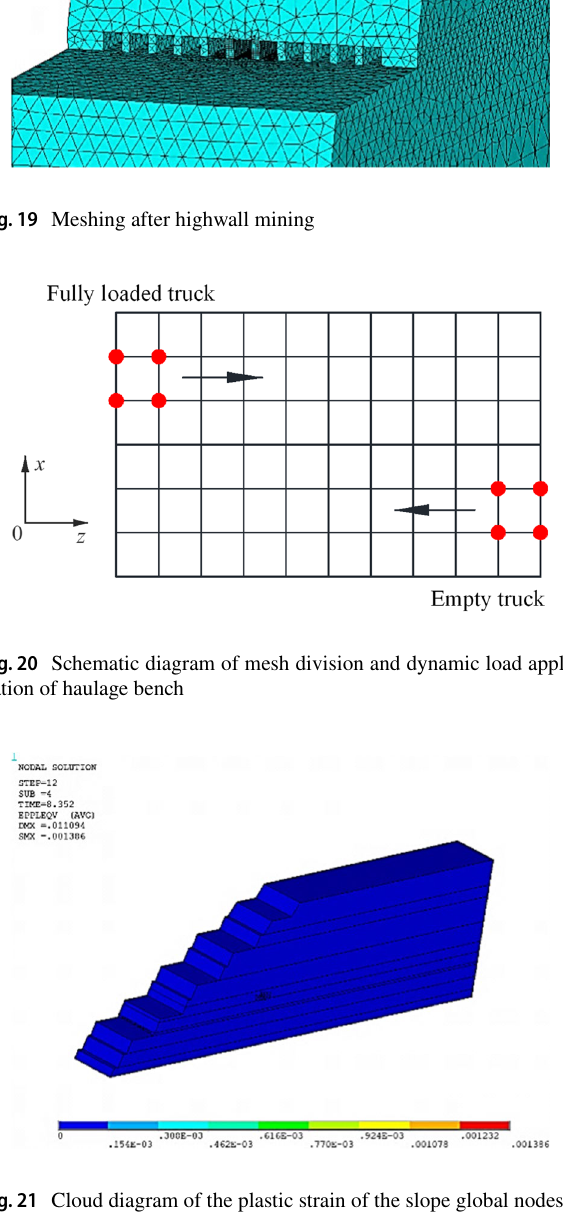
Table 2 Verification results of the rib pillar under different haulage benches Number of haulage bench